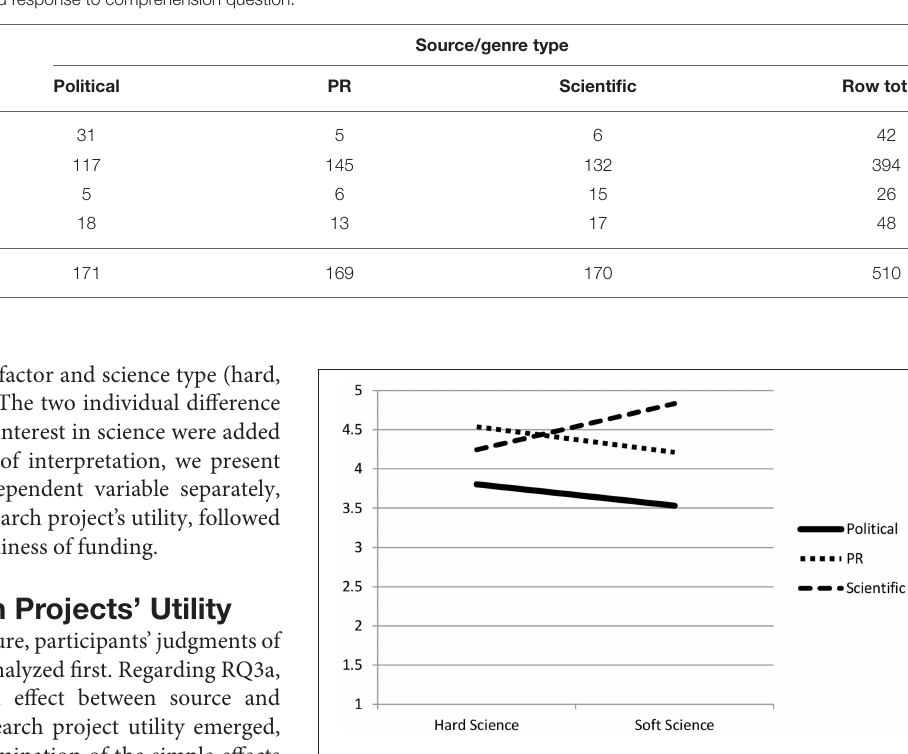
FIGURE 1 | Two-way interaction effect between message and science type on judgments of research project